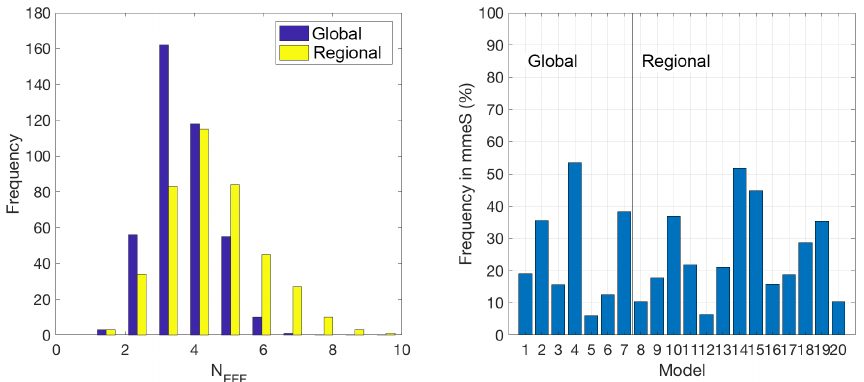
Figure 7. Effective number ( N eff ) of models calculated according to Bretherton et al. (1999) for the two groups of models, and frequency of contribution of each model to the